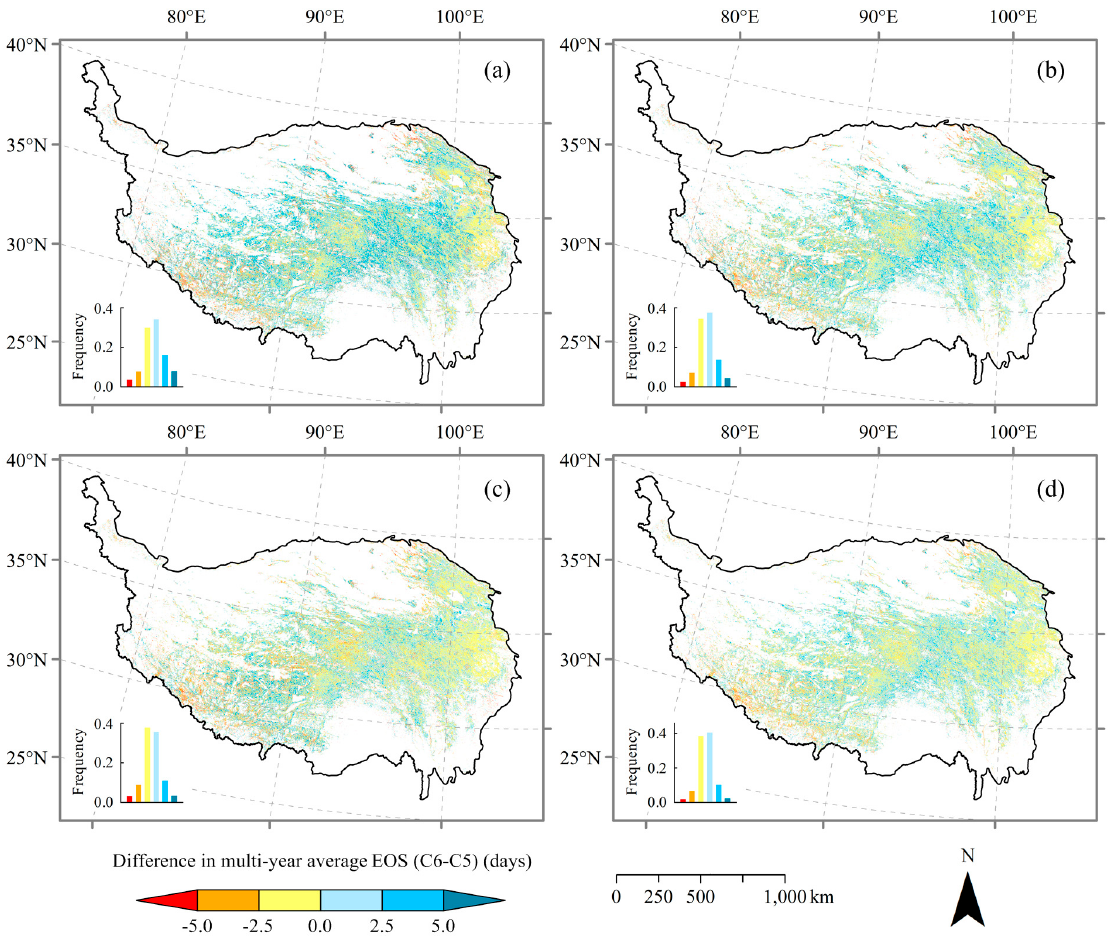
Figure 7. Spatial differences between the multi-year average EOS C6 and EOS C5 (C6–C5) for different methods: ( a ) Maximum Curvature Change (MCC); ( b ) Dynamic Threshold 0.2 (DT2); ( c ) Dynamic Threshold 0.5 (DT5); and, ( d ) Maximum Slope (MS).